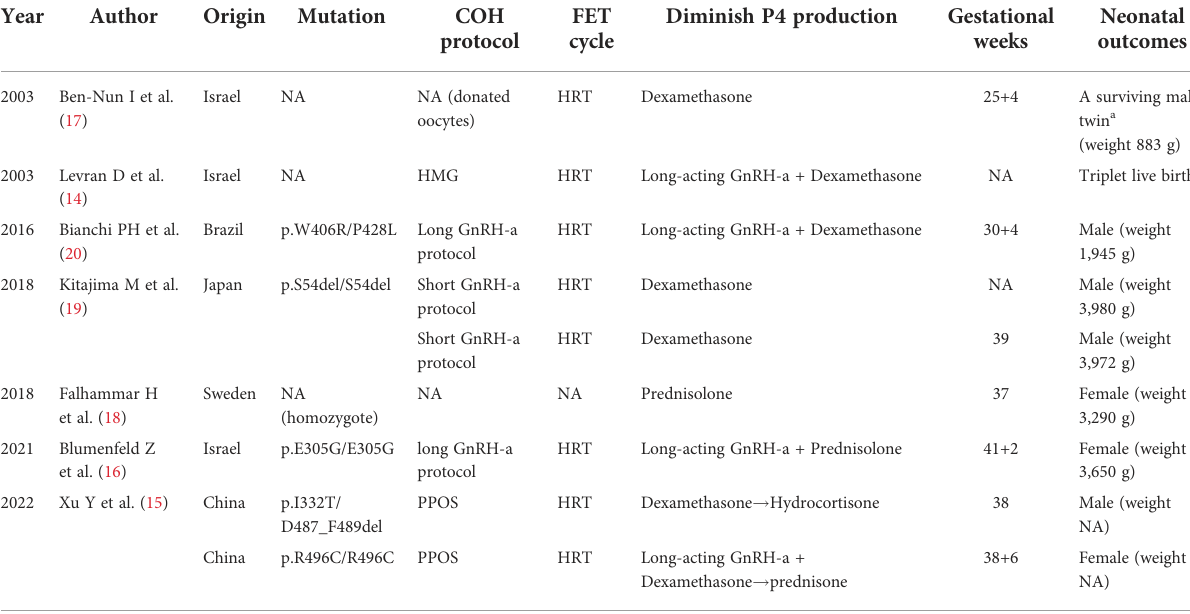
TABLE 5 Previous literature of live births achieved by 17-OHD women undergoing